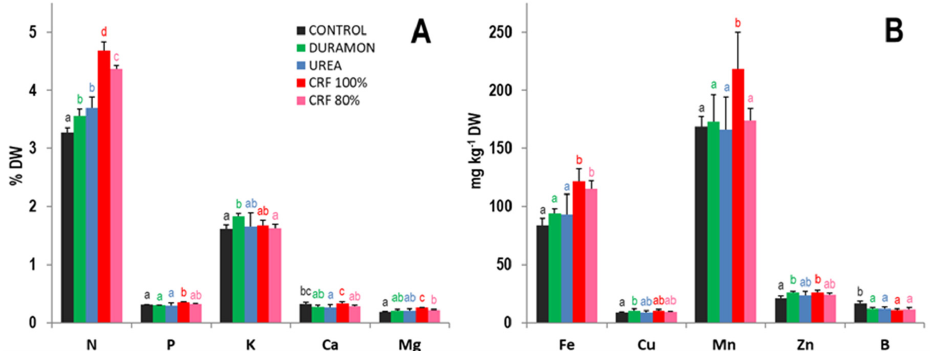
Figure 4. Macro- ( A ) and micronutrient ( B ) foliar content, on the microscale experiment, in rice fertilized with CRF, CRF r2 , DURAMON ® , UREA, and CONTROL (no fertilizer applied), in the phenological booting stage. The macronutrients results (N, P, K, Ca, Mg, and S) are expressed as percentage ( w/w ) of leaf dry mass (DW), and micronutrients as mg kg ‐ 1 leaf DW. Values are means ± SD, n = 4 (pools of ≥ 10 leaves). Different letters for a specific macro ‐ or micronutrient in each panel indicate statistically significant differences between treatments (ANOVA, p < 0.05).